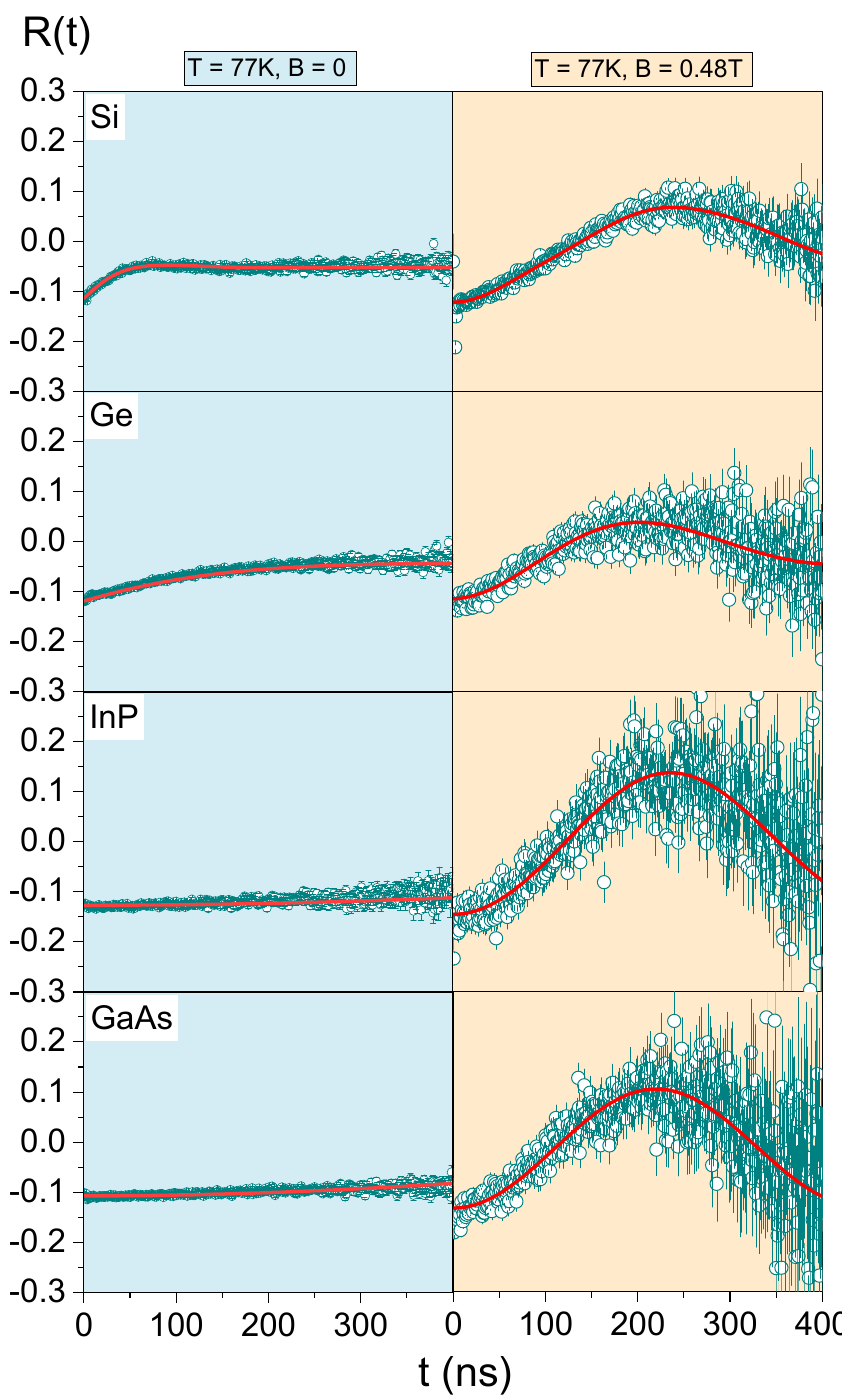
Figure 3. The PAC spectra measured at 77 K with 0 T (blue layer) and 0.48 T (beige layer) magnetic fields. Table 3. Atomic (covalent) radii in Ångstroms